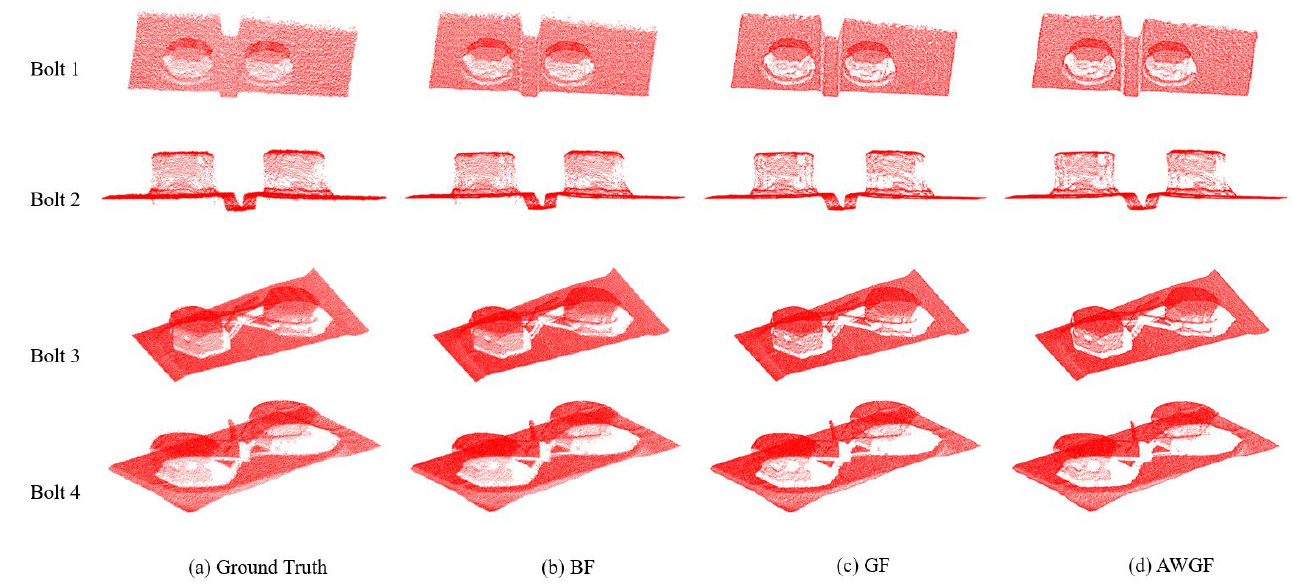
Figure 6. Comparison results of the smoothing.